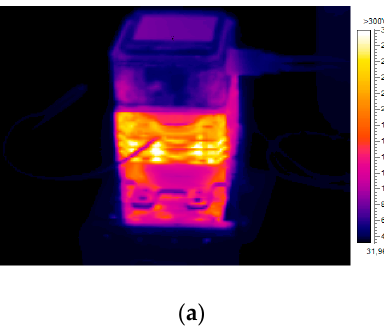
Figure 27. Thermal camera picture ( a ) heated magnetron; ( b ) heated MOT.